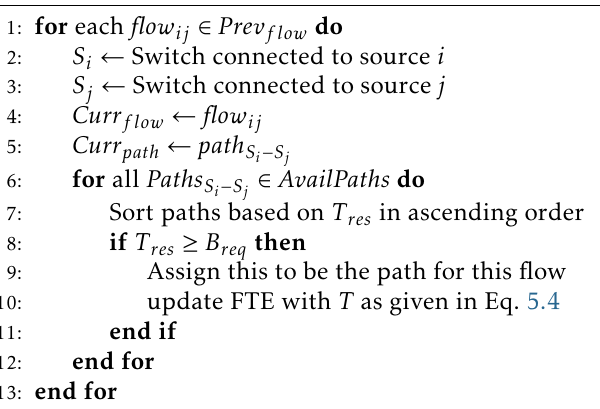
Algorithm 4 - SAND: Re-engineering